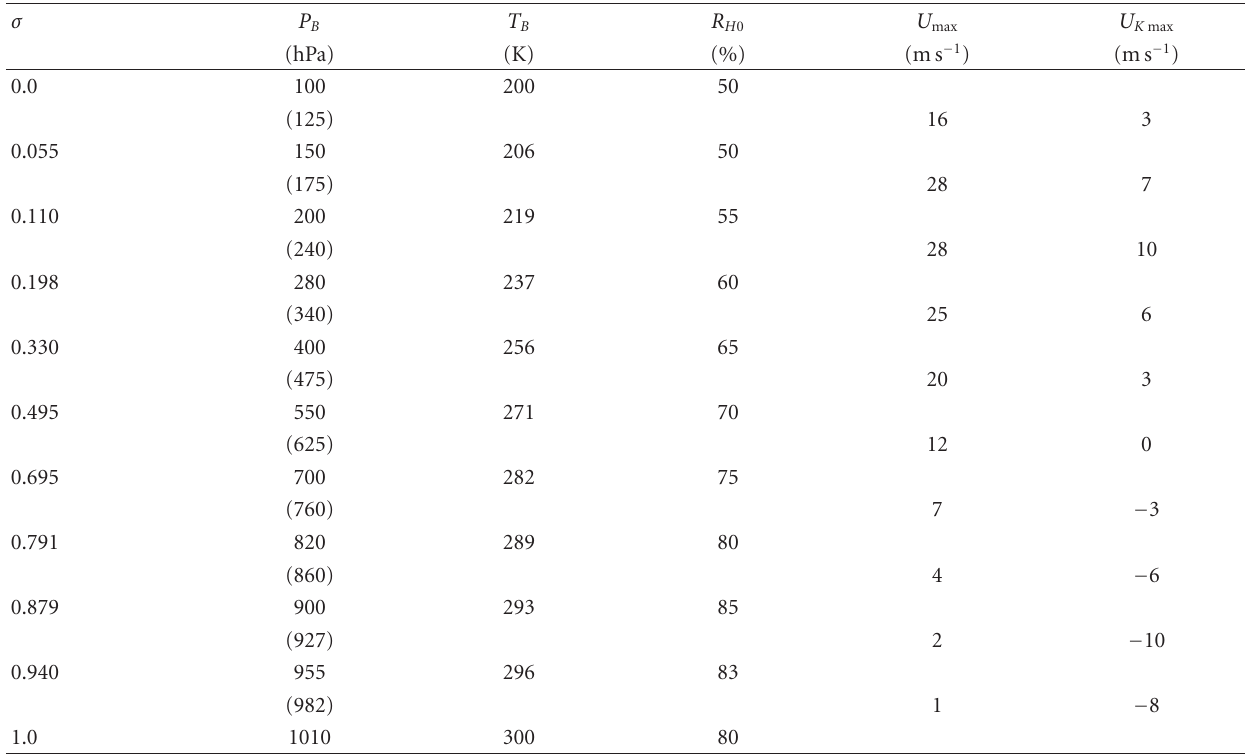
Table 1: Values of σ at 11-levels where vertical σ -velocities are predicted, the corresponding basic state pressure P B , basic state temperatures T B , relative humidity at the center of a moist area R H 0 , maximum values of the basic state zonal velocity in the middle latitudes, and those of the zonal velocity of a wave given at the initial